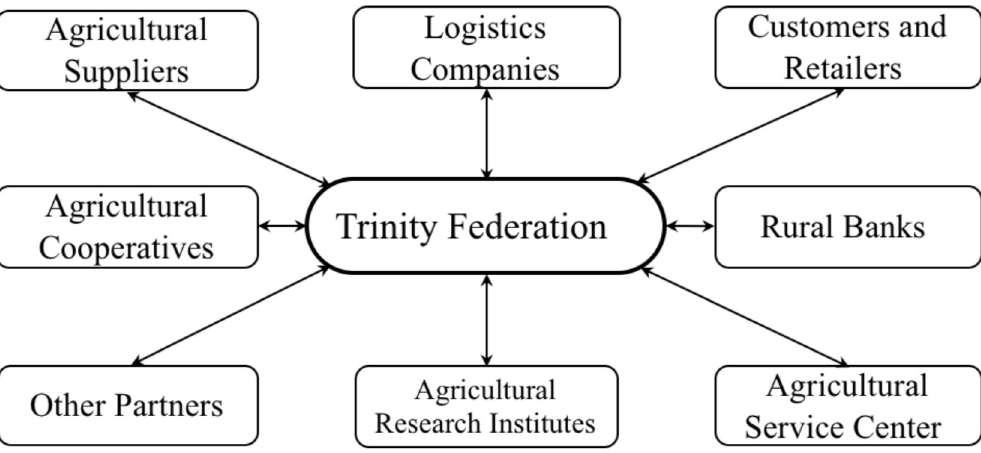
Fig 2. The external integration of the trinity